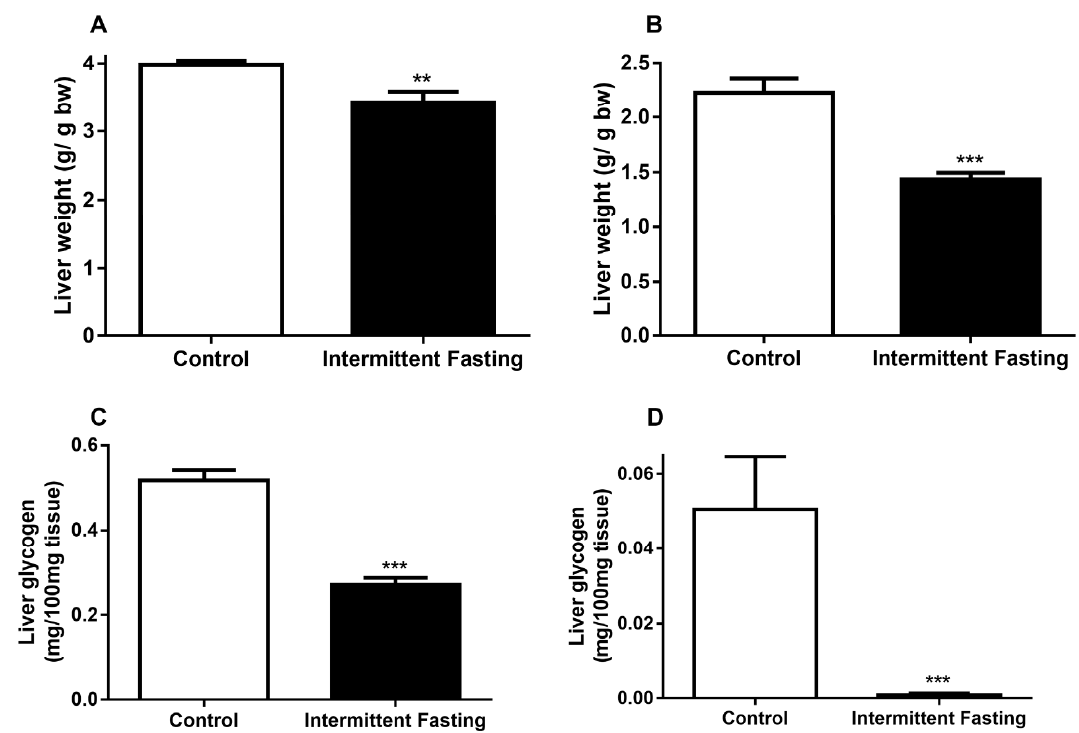
Figure 5. ( A ) Liver weight before and ( B ) after 24h of fasting, ( C ) liver glycogen content before and